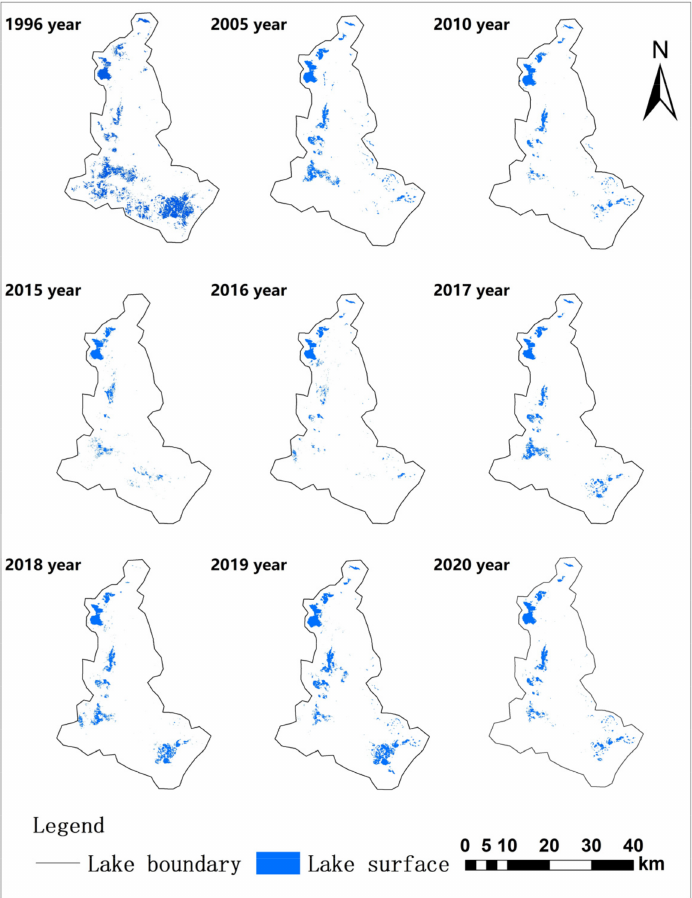
Figure 3. Schematic diagram of the time of changes in the water surface area of Eichmann Lake.